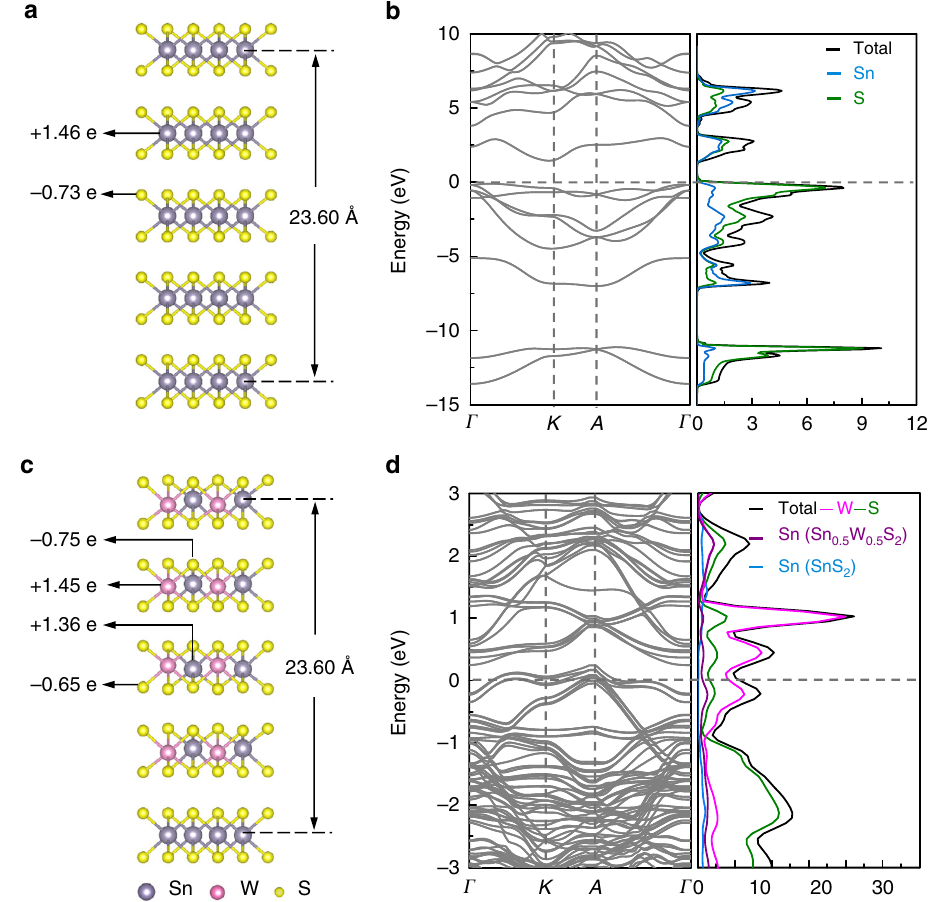
Fig. 4 Calculated electronic structure of SnS 2 and Sn 0.5 W 0.5 S 2 /SnS 2 heterostructures. a Optimized crystal structure with calculated Bader charges. b Band structure and DOS of a 5-layer SnS 2 , showing an indirect band gap near the Fermi level. c Optimized crystal structure with calculated Bader charges. d Band structure and DOS of a four-layer 1T-Sn 0.5 W 0.5 S 2 on a monolayer 1T-SnS 2 , showing the intrinsic metallic characteristic. The Fermi level is assigned at 0